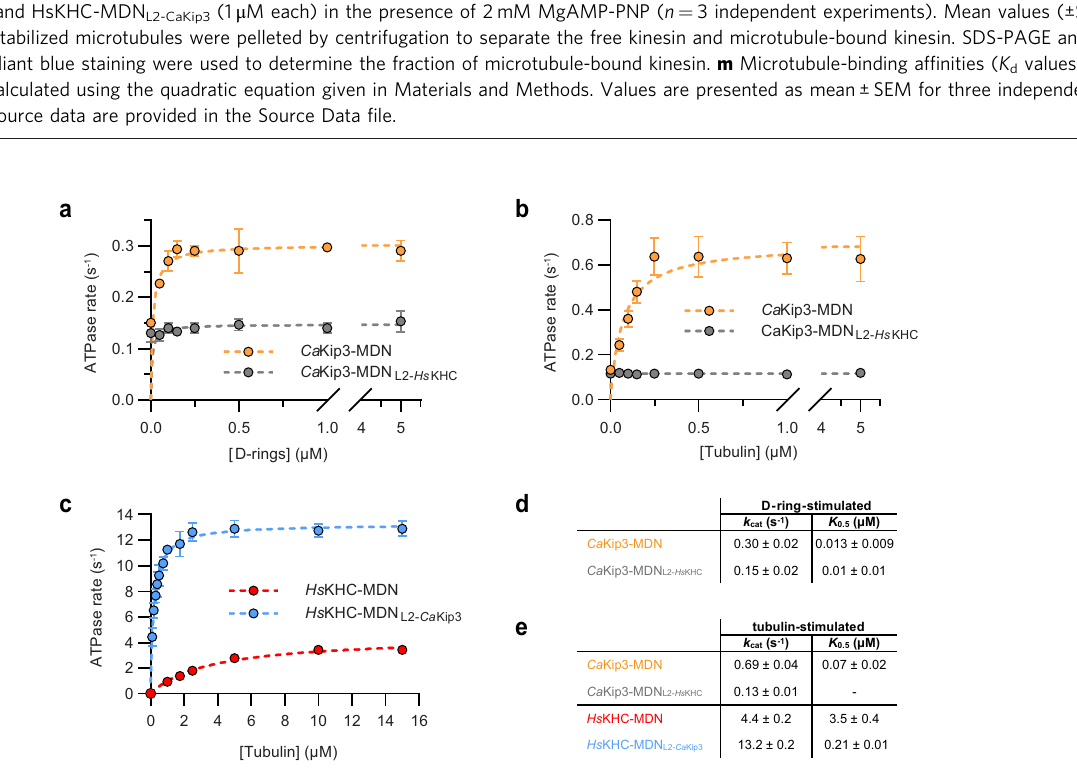
Fig. 4 Structures and activity of loop-2 swap mutants on microtubules. Cryo-EM map of a MT- Ca Kip3-MDN L2- Hs KHC in the APO state, b MT- Ca Kip3- MDN L2- Hs KHC in the AMP-PNP state, and c MT- Ca Kip3-MDN in the AMP-PNP state. d Displacement vectors for C α atoms in CaKip3 and tubulin when comparing the MT-CaKip3-MDN-ANP and MT- Ca Kip3-MDN L2- Hs KHC -ANP complexes. Structures were aligned to the β -tubulin chain of MT- Ca Kip3-MDC- ANP. Displacement vectors for C α atoms are colored regionally to match the segment of the protein model that is compared, using the color scheme in Fig. 1. MT- Ca Kip3-MDN-ANP structure is shown as semi-transparent colored ribbons using the same regional color scheme as in Fig. 1. Only vectors with a magnitude of 1.0 Å or higher are shown. e , f Microtubule-gliding assay velocity distributions for Ca Kip3-MDN, Ca Kip3-MDN L2- Hs KHC , Hs KHC-MDN, and Hs KHC-MDN L2- Ca Kip3 using taxol-stabilized microtubules. n = 3 independent experiments for each protein. Asterisks indicate two-tailed unpaired t -test signi fi cance: p = 1.3e-135, p = 3.8e-122 for e and f , respectively. g Summary of motor velocities. Values are presented as mean ± SEM. h Microtubule- stimulated ATPase kinetics of Ca Kip3-MDN and Ca Kip3-MDN L2- Hs KHC at steady state ( n = 3 independent experiments). The basal rate was 0.13 ± 0.01 s − 1 for both motors. Mean values (±SD) are shown. i Microtubule-stimulated ATPase kinetics of Hs KHC-MDN and Hs KHC-MDN L2- Ca Kip3 at